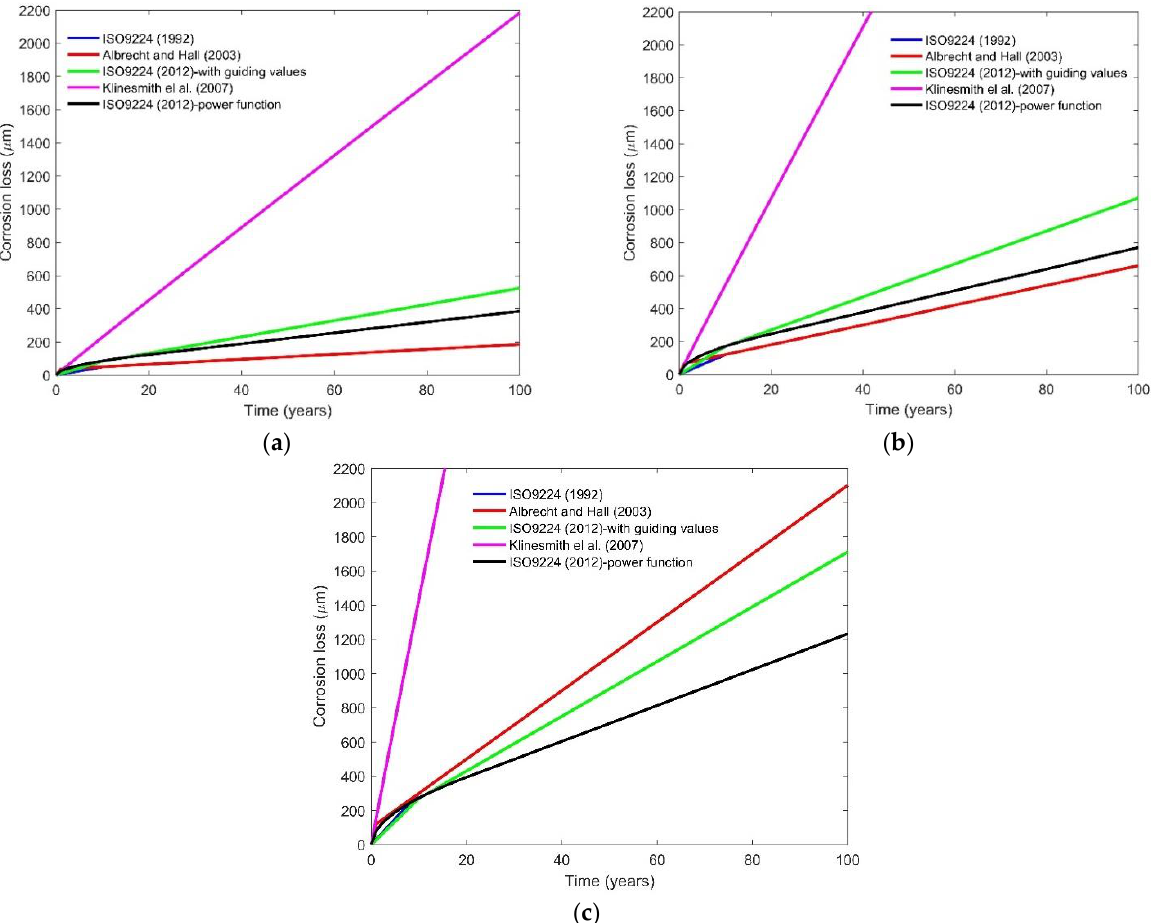
Figure 4. Comparison between different corrosion models: ( a ) C2; ( b ) C3; ( c ) C4 corrosivity level.